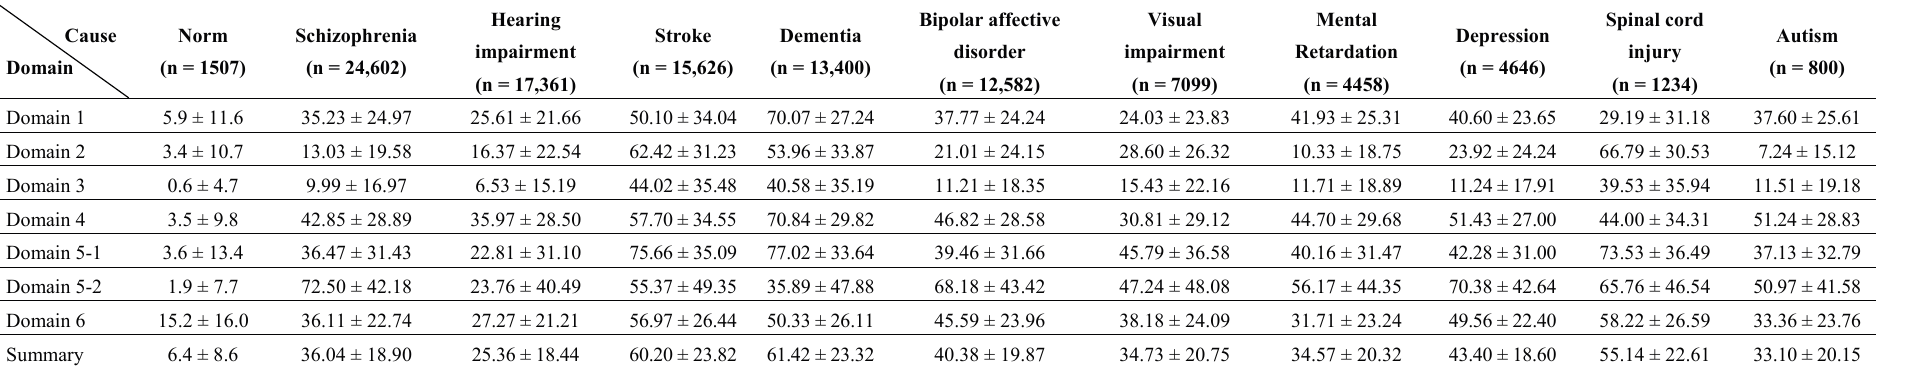
Table 2. Domain and summary scores of WHODAS 2.0 according to causes of disability (n = 101,808).